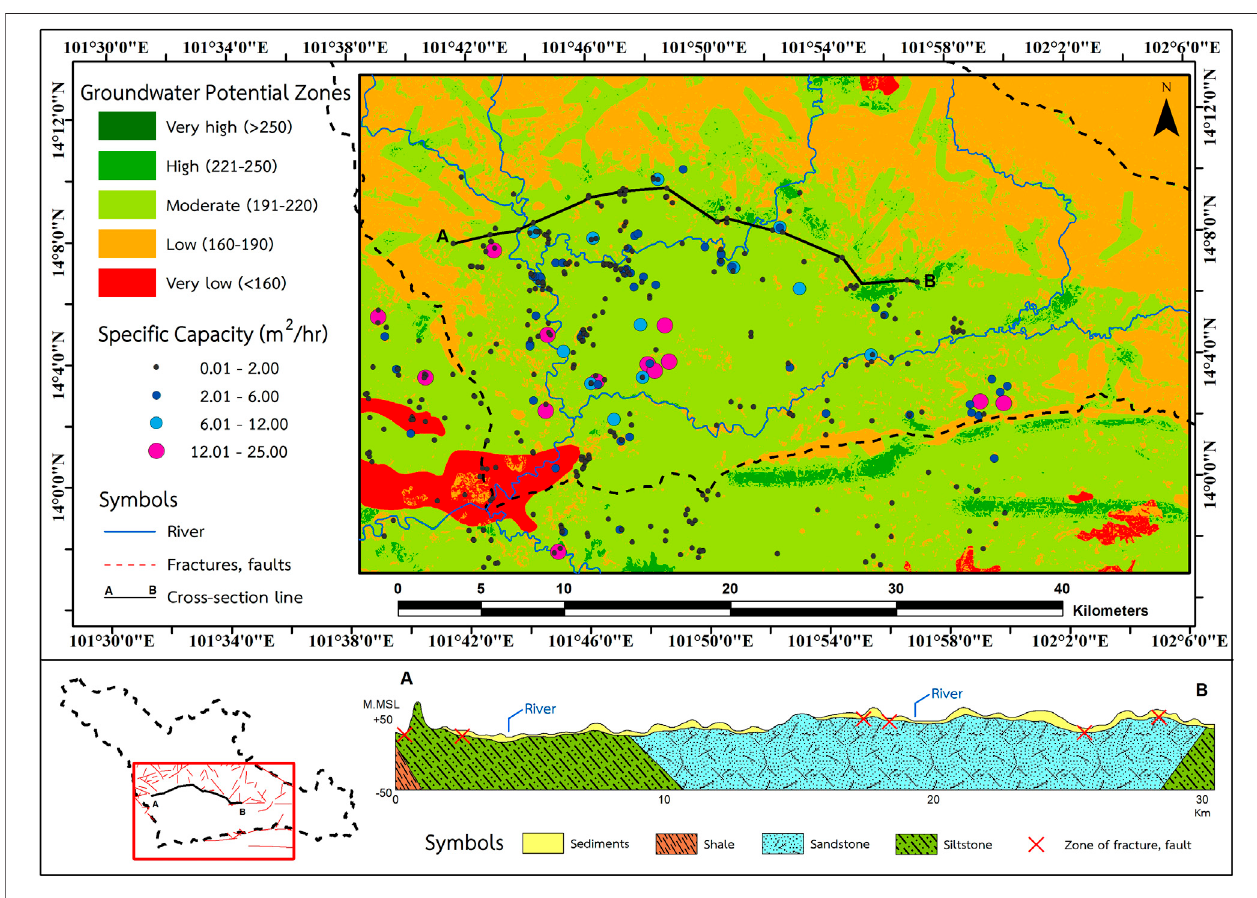
FIGURE 6 | GRP map of the LKH sub-basin, Prachin Buri Province, Thailand.